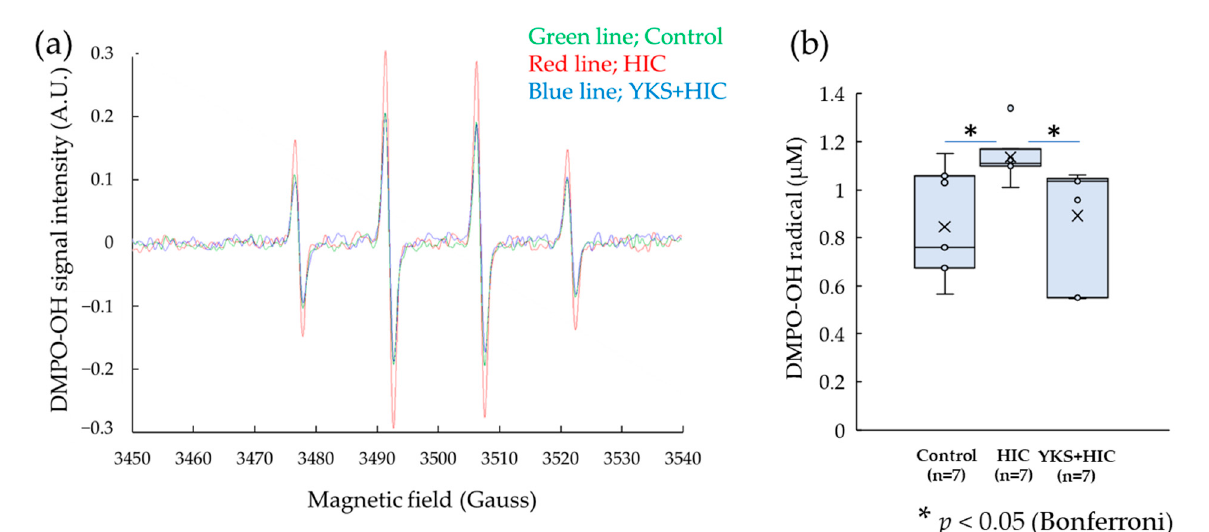
Figure 5. Oxidative Stress Parameters. ( a ) d-ROMs test; ( b ) 8-OHdG. Horizontal lines within boxes denote median values, and x marks denote the mean values. * Significant difference ( p < 0.05) (Krus- kal–Wallis test with the post hoc test and Bonferroni correction). ( c – h ) Immunofluorescent staining of 8-OHdG in the bladder. The upper row ( c – e ) includes only 8-OHdG, and the lower row ( f – h ) includes 8-OHdG and nuclei. Red, 8-OHdG; blue, DAPI (nuclei). The white scale bar is 200 μ m. HIC, Hunner type interstitial cystitis; YKS, Yokukansan; d-ROMs, diacron reactive oxygen metabolites; 8-OHdG, 8-hydroxy-2 ′ -deoxyguanosine; DAPI, 4 ′ ,6-diamidino-2-phenylindole. 4. Discussion In the present study, the administration of YKS inhibited bladder pain-like behavior and suppressed the increase in expression of oxidative stress markers in the bladder wall in a rat model of HIC. Kampo formulae were reported to have certain antioxidant activity [21,22]. In this study, the ·OH scavenging capacity of YKS was verified by comparing it with that of ascorbic acid, which is a well-known antioxidant agent. The result showed that ascorbic acid exhibited higher ·OH scavenging capacity than YKS. However, YKS exhibited higher ·OH scavenging capacity when adjusted for the daily dose. We will also compare these antioxidant effects in vivo. YKS contains many ingredients, and all its main ingredients, such as liquiritin [38], liquiritin apioside [39], and ferulic acid [40], have antioxidant ca-